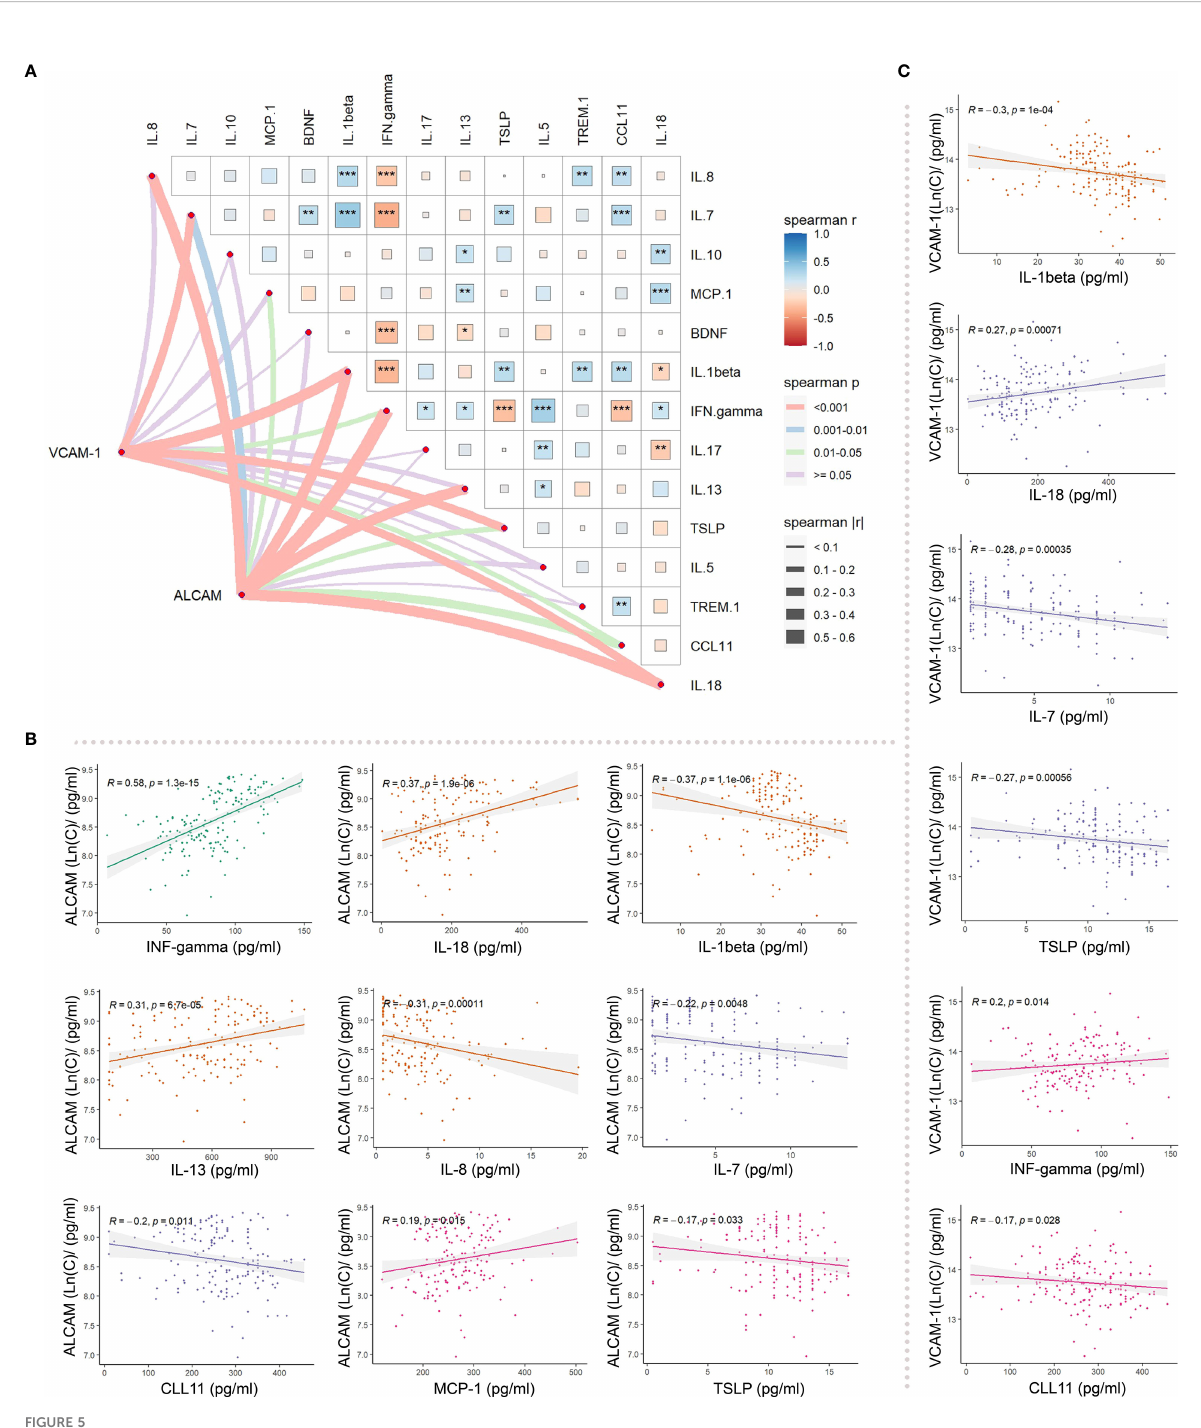
FIGURE 5 Differences in the correlation between ALCAM, VCAM_1, and in fl ammatory factors in participants with AD: (A) Spearman correlation analysis revealed an association of ALCAM with IFN-gamma, IL-18, IL-1beta, IL-13, IL-8, IL-7, CCL11, MCP-1 and TSLP. VCAM-1 was correlated with IL- 1beta, IL-18, IL-7, TSLP, IFN. gamma, and CCL11. (B) ALCAM was signi fi cantly correlated with IFN- gamma (r=0.58, p<0.001), IL-18 (r=0.37, p<0.001), IL-1beta (r=-0.37, p<0.001), IL-13 (r=0.31, p<0.001), IL-8 (r=-0.31, p<0.001), and IL-7 (r=-0.22, p<0.001). (C) VCAM-1 was signi fi cantly correlated with IL-1beta (r=-0.3, p<0.001), IL-18 (r=0.27, p<0.001), IL-7 (r=-0.28, p<0.001), and TSLP (r=-0.27, p<0.001). * represents the signi fi cance of correlation ( “ *** ” : p-value<0.001, “ ** ” : p-value<0.01, “ * ” : p-value<0.05, “ ” :